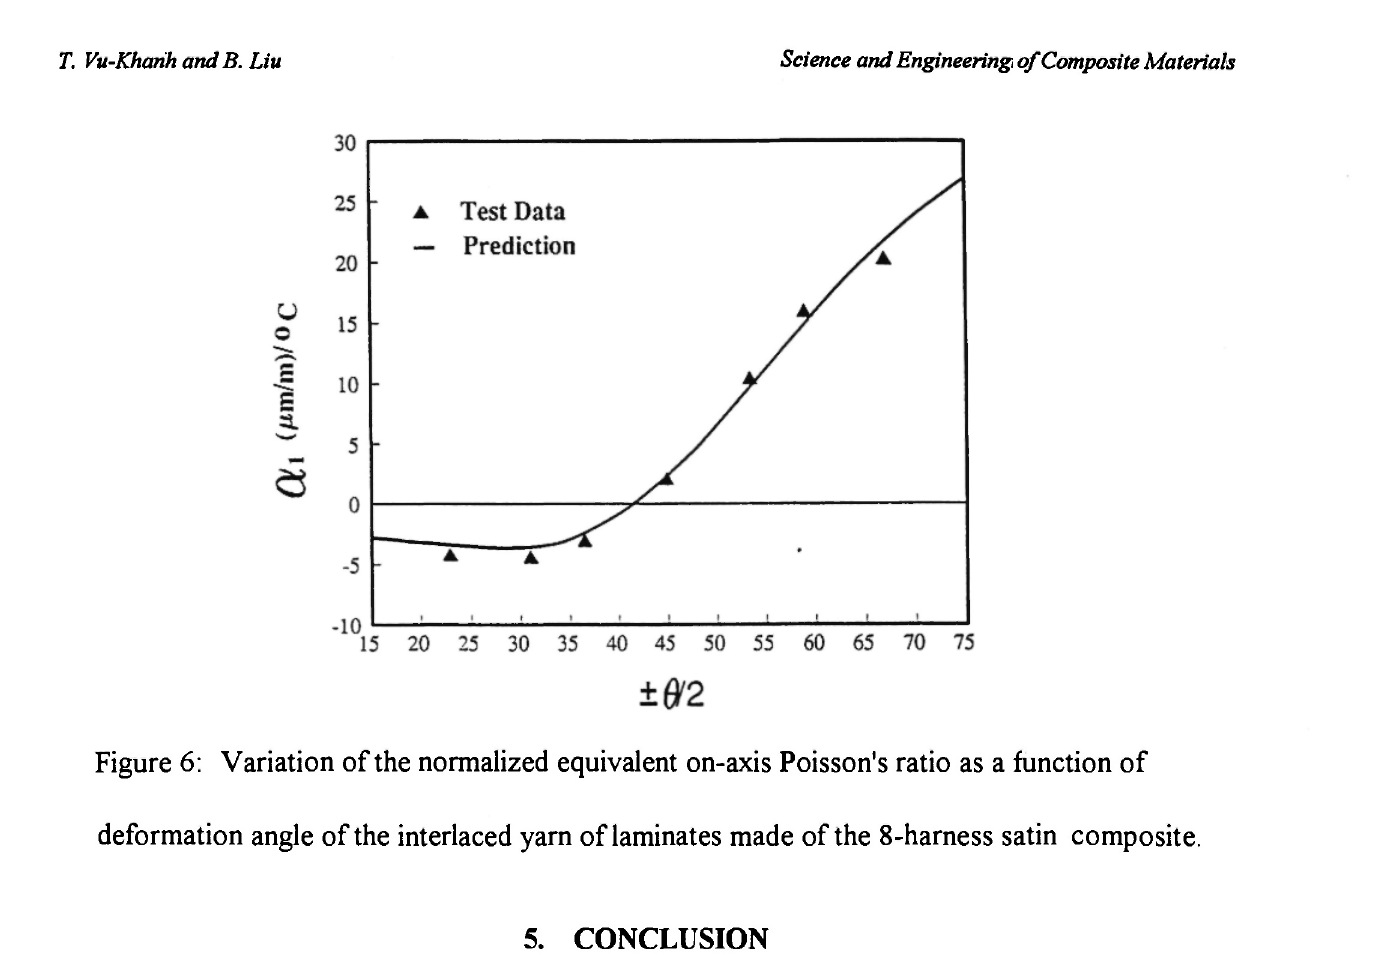
Figure 6: Variation of the normalized equivalent on-axis Poisson's ratio as a function of deformation angle of the interlaced yarn of laminates made of the 8-harness satin